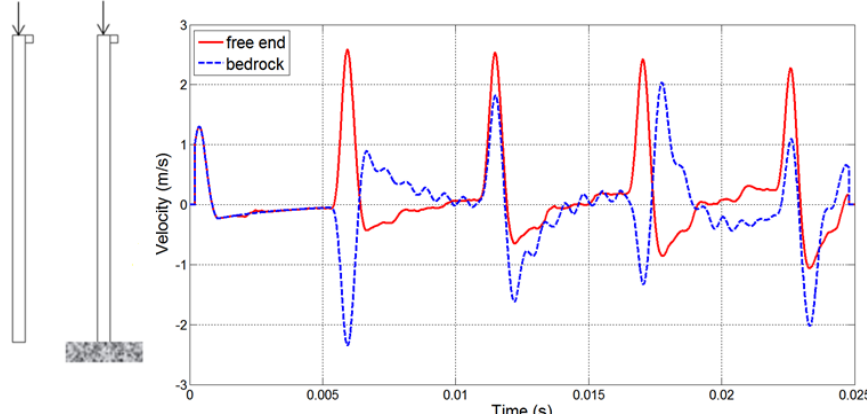
Figure 5. Wave comparison between two different boundary conditions.